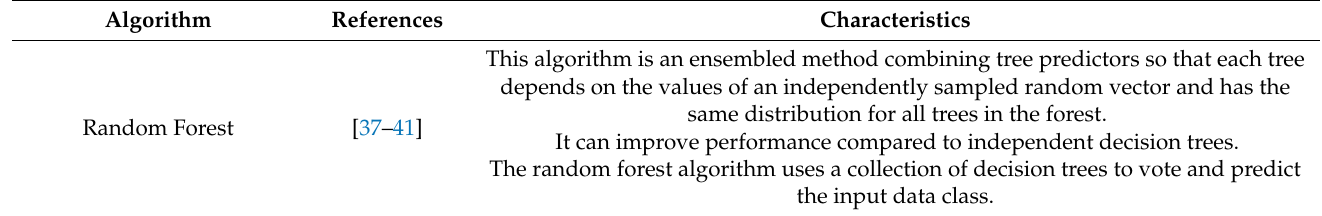
Table 2. Machine learning